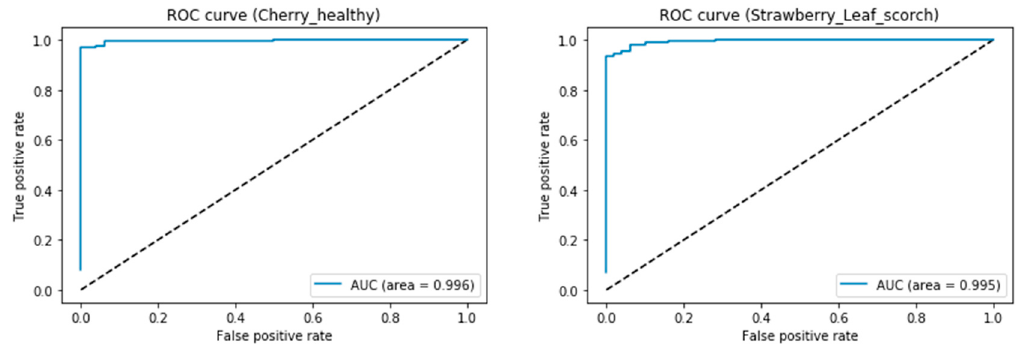
Figure 6. Sample AUC-ROC curves of 14-DCNN.